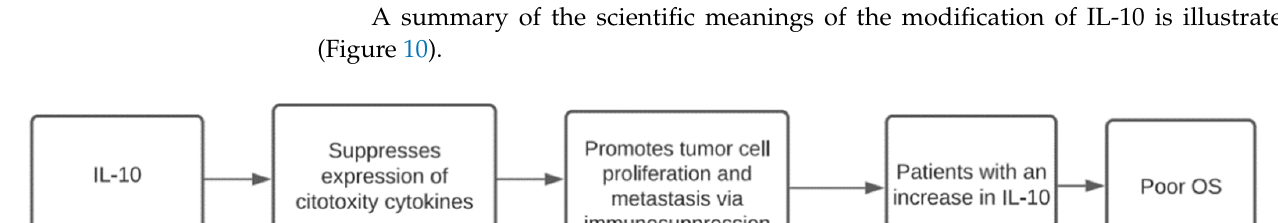
Figure 9. Cox analysis for OS between pts (blue line) which show IL-10 values at t1 lower than t0 (t1 < t0) or lower than a cut-off value of increment defined by ROC analysis (0.6 pg/mL) and pts (green line) which show an increment above the cut-off value (0.6 pg/mL) at t1 compared to at t0. (HR: 0.291; 95% CI: 0.103–0.822; p = 0.020).